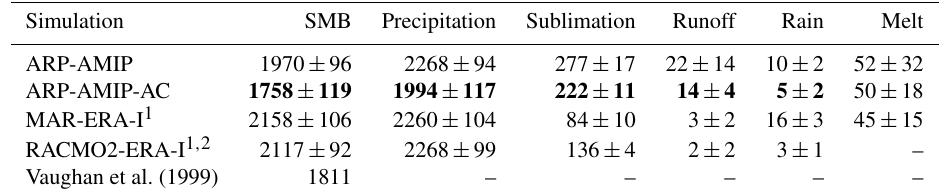
Table 4. Mean GIS surface mass balance and its components (Gtyr − 1 ) ± 1 standard deviation of the annual value for the reference period 1981–2010. ARPEGE values are integrated over the original model grid and take into account the model land mask. ARPEGE, 1 MAR and RACMO2 ERA-Interim-driven statistics for 1981–2010 for the Antarctic GIS using MAR grounded ice masks (GIS area = 12.37 × 10 6 km 2 ). 2 RACMO2 original data source is van Wessem et al. (2018). Statistics in bold for ARP-AMIP-AC are statistically different from ARP-AMIP at p = 0 . 05.